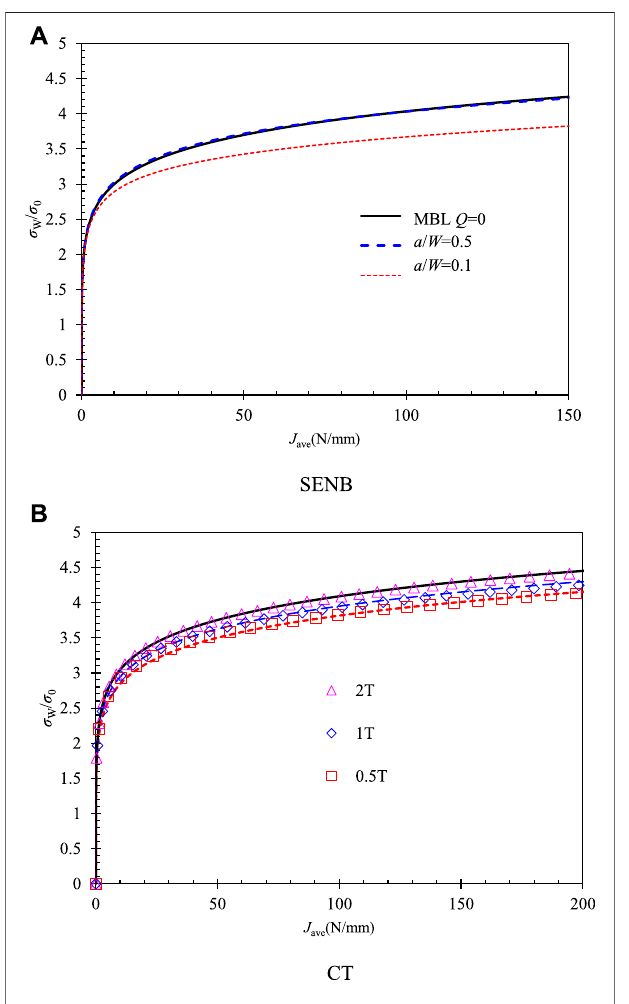
FIGURE10| Weibullstressvariedwiththeapplied J averagefordifferent models. (A) SENB. (B) CT.